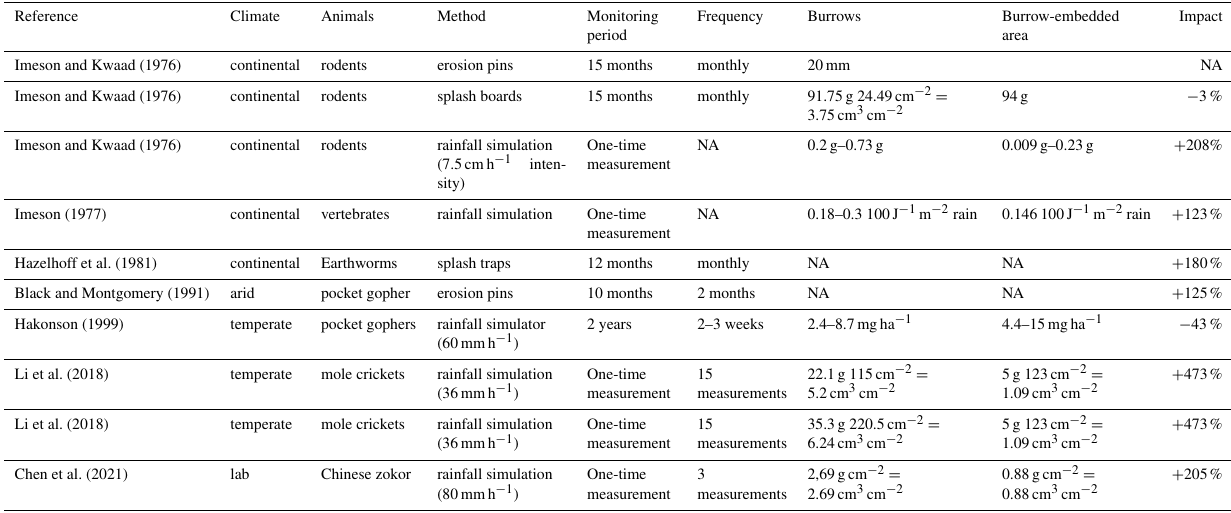
Table A6. Review of studies that estimated the sediment redistribution within burrows and burrow embedding areas and the proposed impact. NA stands for data not available.